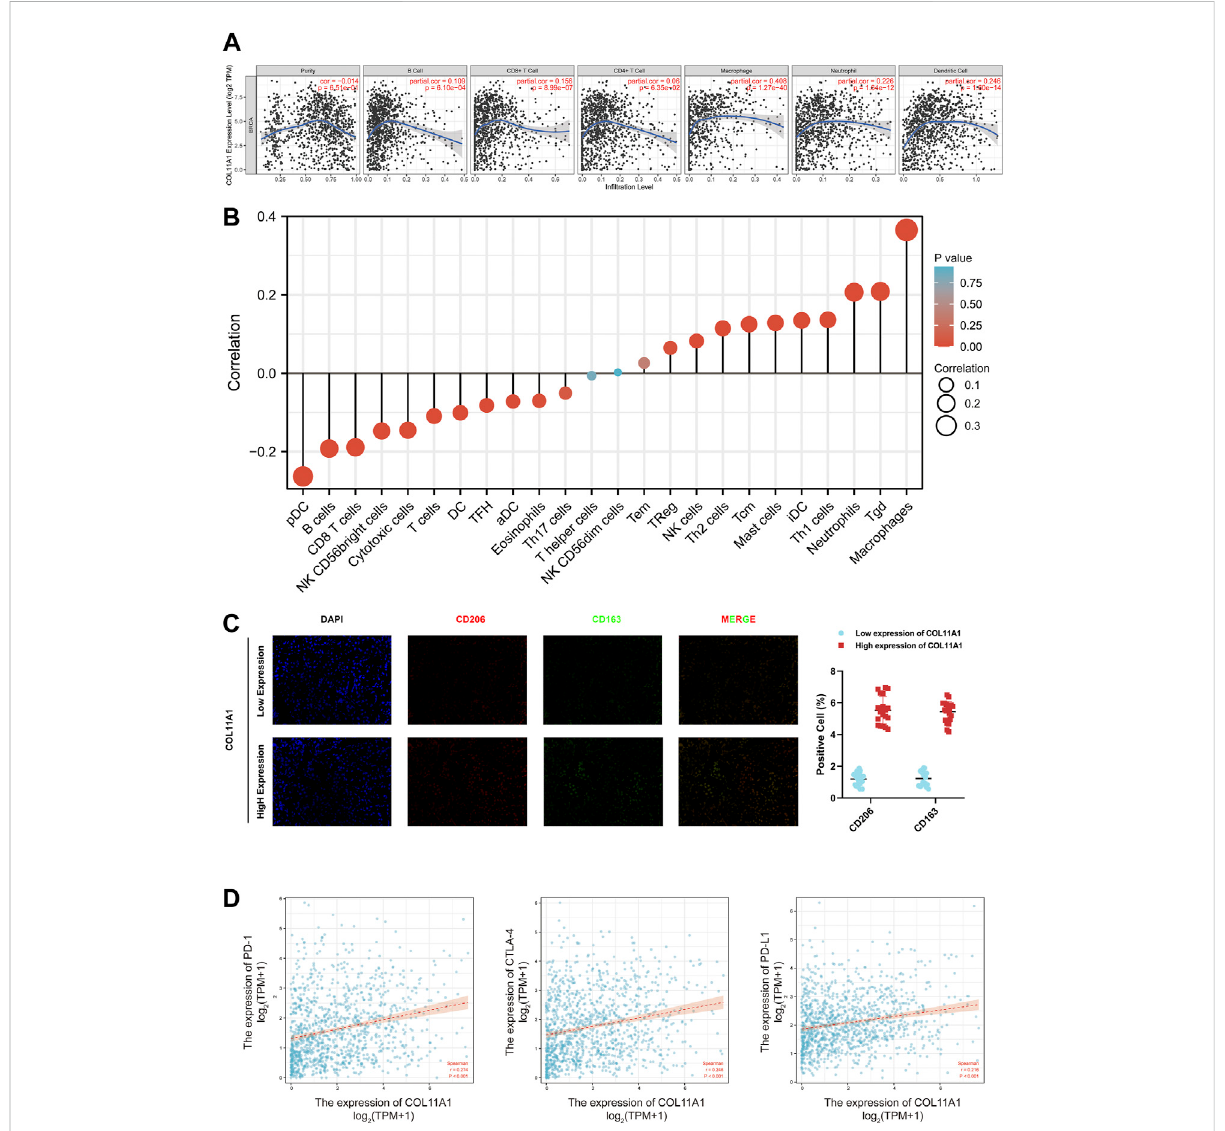
FIGURE 6 Correlation of COL11A1 expression with immune in fi ltration levels. (A) COL11A1 was signi fi cantly correlated with tumor purity and positively correlated with different immune cell in fi ltration using the TIMER database. (B) COL11A1 expression was signi fi cantly correlated with immune cell in fi ltration in breast cancer using the Lollipop chart. (C) Immuno fl uorescence staining labeled two biomarkers, CD206 and CD163, of macrophages in breast cancer tissues; (D) The correlation between COL11A1 expression and PD-1, PD-L1 and CTLA-4 in BRCA using TCGA database Scatter plot of